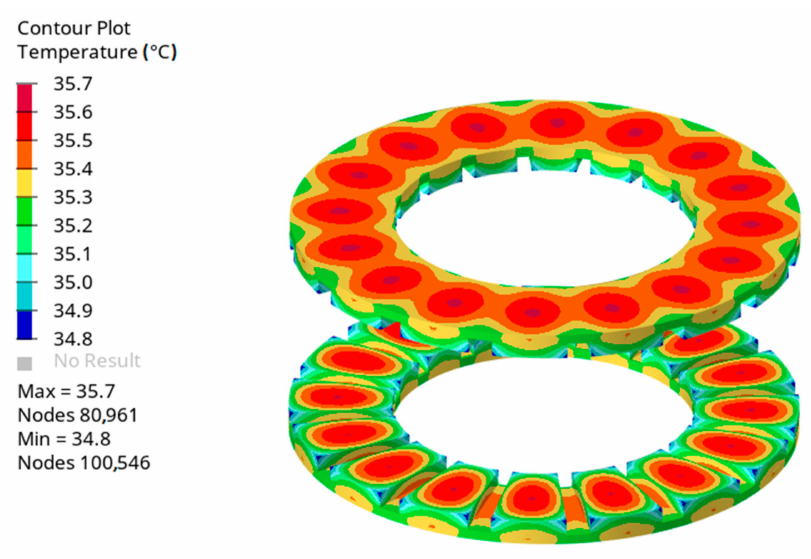
Figure 22. The temperature distribution in the rotor discs with PMs.